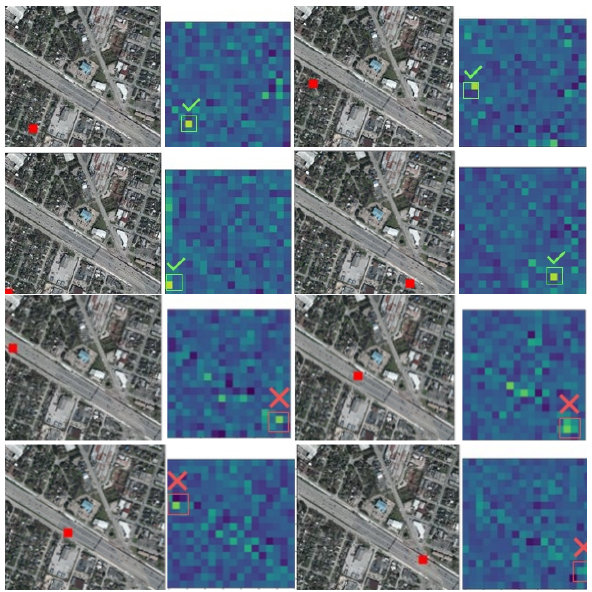
Figure 5. Heat map generated from the similarity matrix between the target patch DEM and all RGB patches.